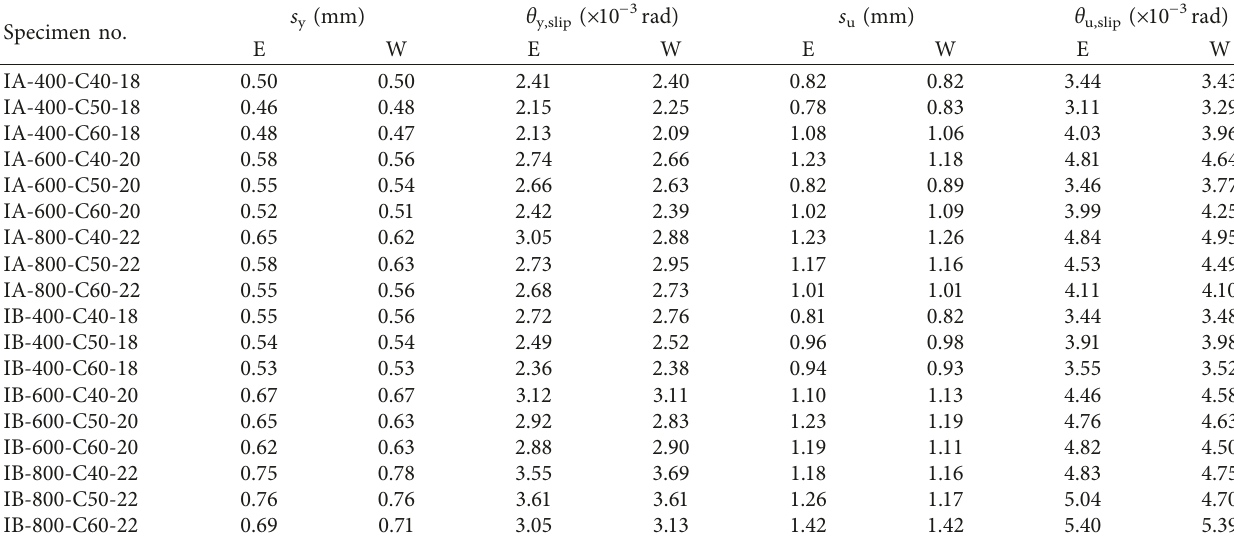
Table 7: Additional fixed-end rotation of interior beam-column connection at yielding and nominal ultimate limit states. Specimen